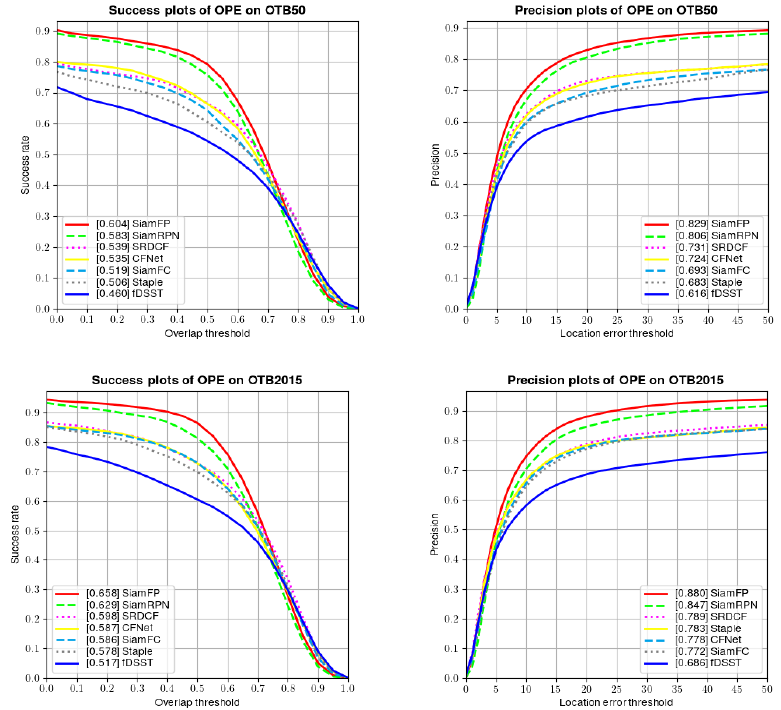
Figure 4. The Precision Plots and Success Plots on OTB50 and OTB2015 Dataset.